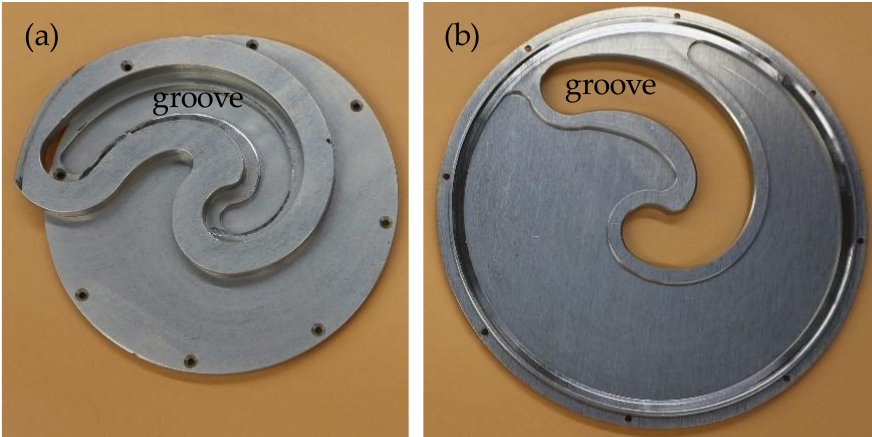
Figure 14. Cam prototype based on optimal load distribution: ( a ) cam C 1 ; ( b ) cam C 2 . Physical prototype and experiment platform. After the cam group is installed coaxially, a common cam groove is formed. Joint B is set at the common groove through a common shaft (Figure 15a) and its position is decided by the cams’ position. By cams differential control, the goal ρ for stiffness adjustment can be set and the stiffness of the VSA would be changed. By cams’ synchronous motion, the deformation angle θ changed. To simplify the measurement, both the housing and the output link (Figure 15b) are bolted with the test frame (Figure 15c) Then the ρ and θ can be obtained after reduction ratio calculation with the encoder value of the dual motors. The output torque can be measured through the internal torque sensor between them.